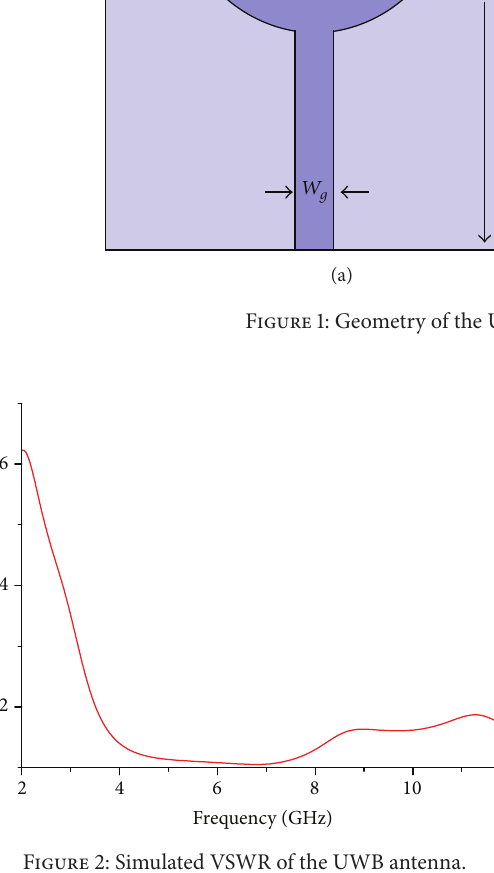
Figure 2: Simulated VSWR of the UWB antenna.